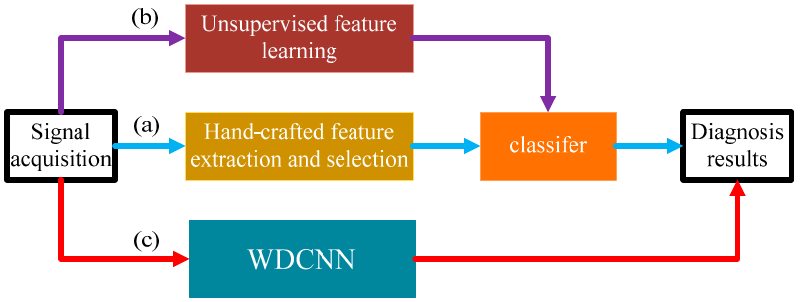
Figure 1. Three intelligent fault diagnosis frameworks: ( a ) traditional method; ( b ) features extracted by unsupervised learning [27]; ( c ) the proposed method.